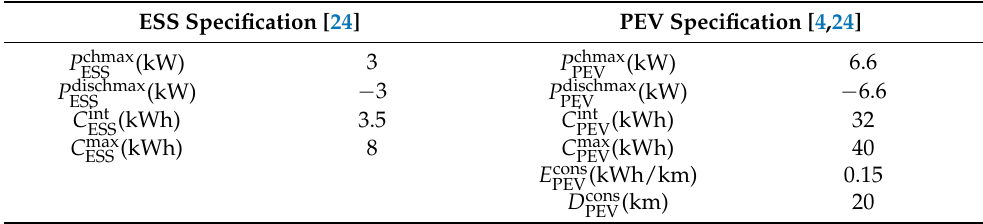
Table 1. ESS and PEV specifications.